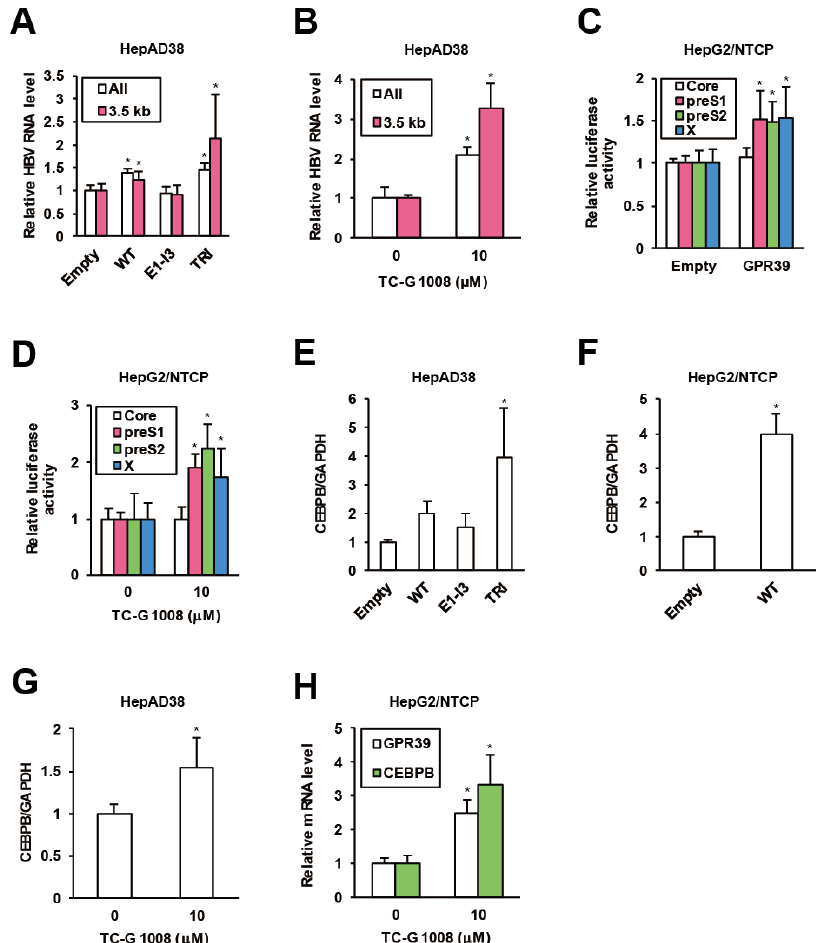
Figure 2. GPR39 supports HBV replication. ( A ) The e ff ects of lentivirally overexpressed GPR39 proteins on HBV RNA. After preculture without tetracycline (Tet) for 7 days, HepAD38 cells were infected with lentiviruses for the empty control, WT, E1-I3 and TRI in the presence of Tet for 6 days. The relative levels of HBV RNAs were measured by qRT-PCR. ( B ) The e ff ects of TC-G 1008 on HBV RNA levels in HepAD38 cells. After preculture without Tet for 7 days, the cells were treated with TC-G 1008 at 10 µ M for 6 days in the presence of Tet. The relative RNA levels of were measured by qRT-PCR. ( C ) The e ff ects of GPR39 on HBV promoter activities. The reporter plasmids carrying viral promoters were cotransfected with the expression plasmid of GPR39 into HepG2 / NTCP cells for 2 days and relative luciferase activities were measured. ( D ) The e ff ects of TC-G 1008 on HBV promoter activities. The reporter plasmids carrying viral promoters were transfected into HepG2 / NTCP cells for 24 h and then treated with TC-G 1008 at 10 µ M for 24 h, followed by the measurement of relative luciferase activities. ( E ) The e ff ects of lentivirally overexpressed GPR39 proteins on CEBPB in HepAD38 cells. After preculture without Tet for 7 days, the cells were transduced with the lentiviruses for 6 days in the presence of Tet. The relative mRNA level of CEBPB was measured by qRT-PCR. ( F ) The e ff ects of lentivirally overexpressed GPR39 on CEBPB in HepG2 / NTCP cells. After the transduction with the lentiviruses for the empty control and GPR39 for 2 days, the relative mRNA level of CEBPB was measured by qRT-PCR. ( G ) The e ff ects of TC-G 1008 on CEBPB expression in HepAD38 cells. The cells were treated as in ( B ) and the relative mRNA level was measured by qRT-PCR. ( H ) The e ff ects of TC-G 1008 on CEBPB expression in HepG2 / NTCP cells. After the treatment with TC-G 1008 at 10 µ M for 2 days, the relative mRNA levels were measured by qRT-PCR. Statistical significances with p < 0.05 to controls were indicated by